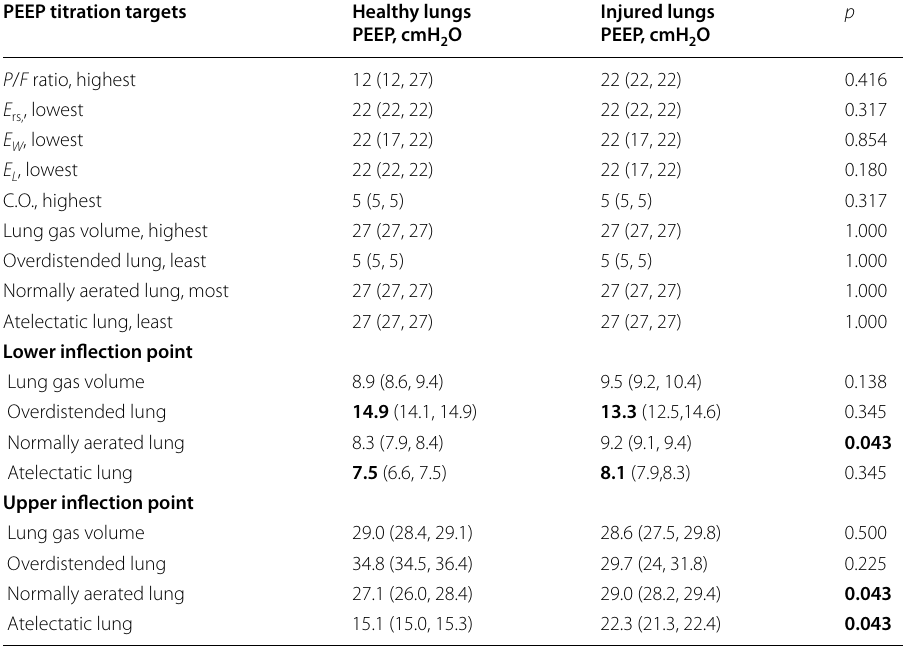
Bold indicates significant p‑values or lower inflection points of atelectatic and overdistended lung with the difference defining an “optimal CT inflation PEEP range” Median (IQR) are